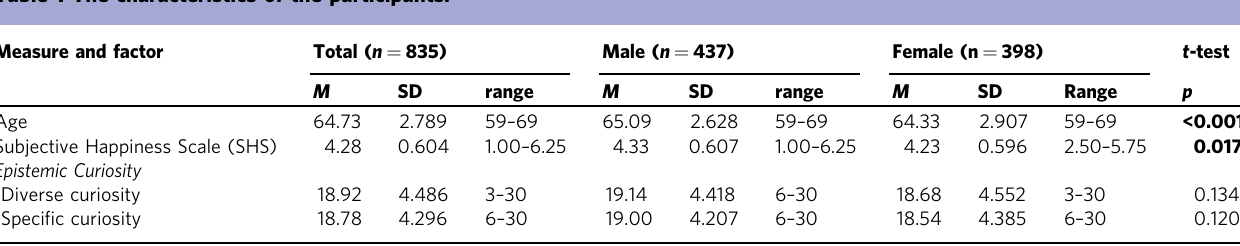
Table 1 The characteristics of the